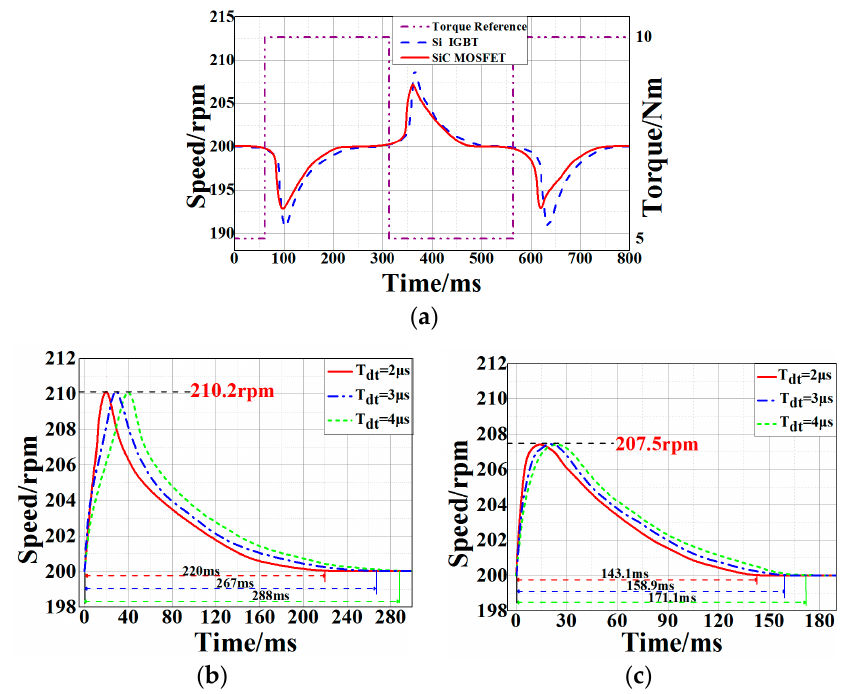
Figure 14. The real speed response curves with the external torque changes suddenly. ( a ) The fluctuations of the speeds at 15 kHz switching frequency and 2 μ s dead time; ( b ) The fluctuations of